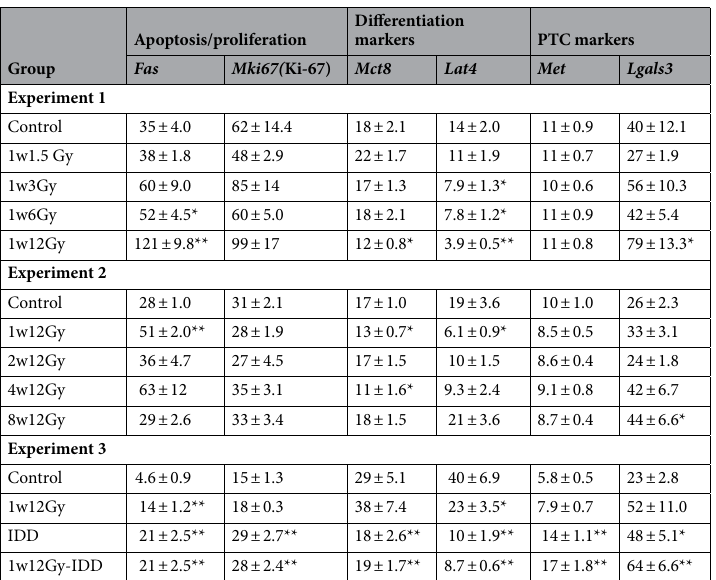
Table 2. mRNA expression of Fas , Mki67 , Mct8 , Lat4 , Met , and Lgals3 in the thyroid of cervically X-irradiated rats. *, and ** indicate significant differences from each control (* p < 0.05; ** p < 0.01).